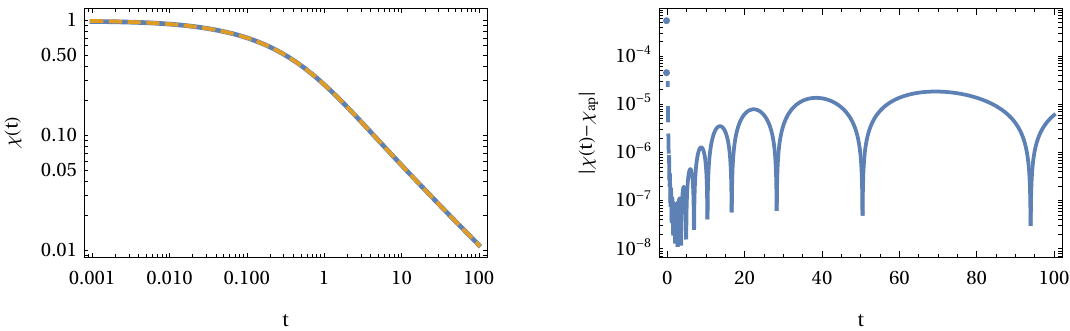
Figure 6. Solution of the fractional relaxation Equation (88) generated by the inverse Laplace transform of ˜ G ( s ) . The left panel also includes the exact solution of the fractional relaxation equation given by χ ( t ) = χ 0 E α ( − ( t / τ ) α ) where E α ( t ) is the Mittag-Leffler function. The right panel shows the local error between the exact solution and the approximation. The number of approximation points used in the calculation was m = 2 N + 1 = 35. The parameters to generate the plot are χ 0 = 1, τ = 1, α = 2/3.